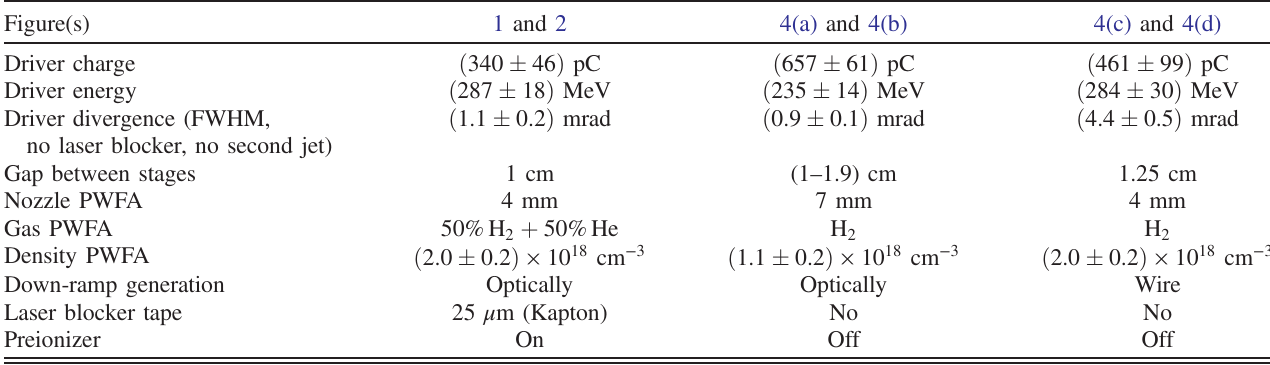
TABLE I. Summary of experimental conditions.